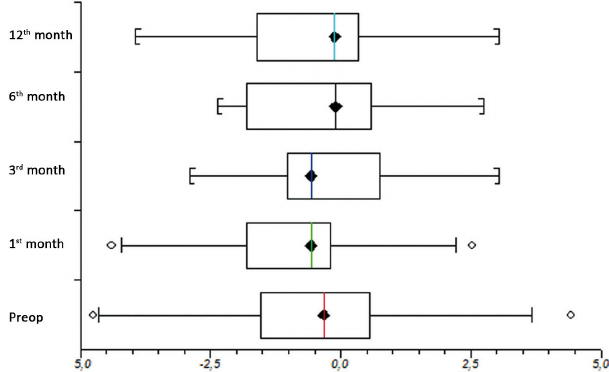
Fig. 9 - Evolution of z-scores for triceps skinfold/age (TSFAZ) in the group of cardiac patients. Analysis of variance with P=0.819. There was no difference with the general